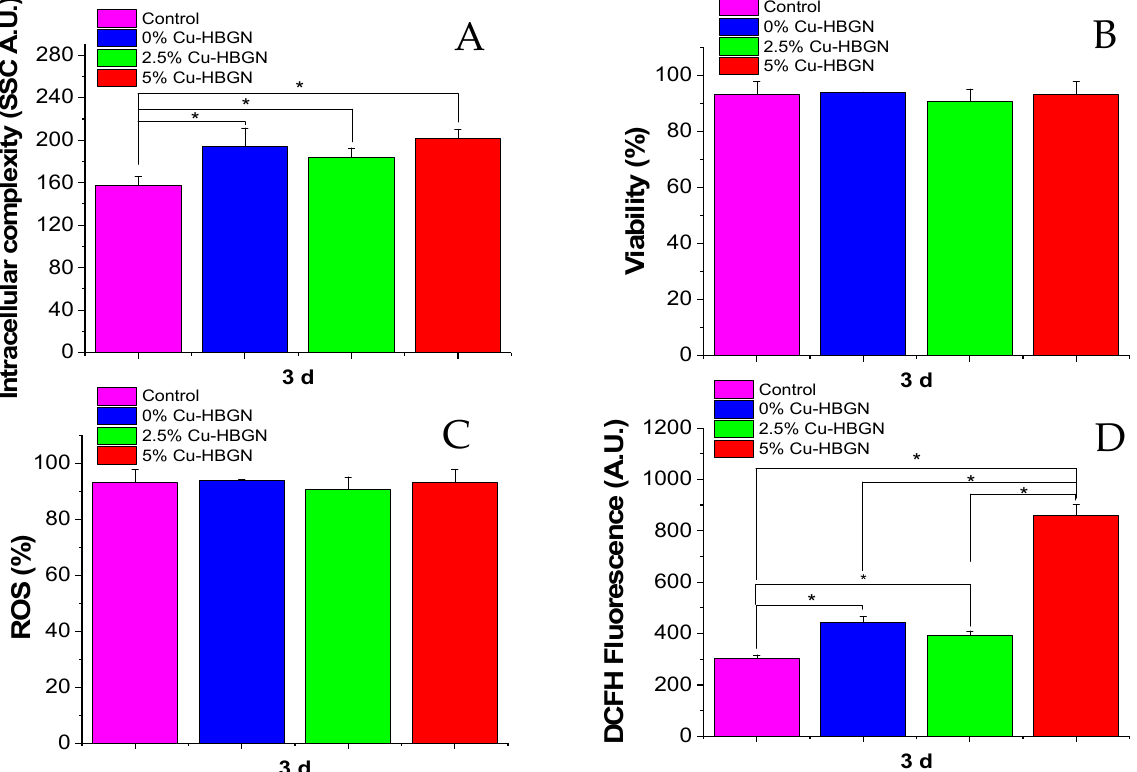
Figure 7. MC3T3-E1 pre-osteoblast exposure to HBGN for 3 d: ( A ) HBGN internalization obtained by intracellular complexity values (SSC), ( B ) viability evaluated by the exclusion of PI positive cells, ( C ) pre-osteoblast populations with ROS intracellular content (%) and ( D ) intensity of DCFH fluorescence, indicative of intracellular ROS content. * Indicates significant differences when p value < 0.05 was obtained.